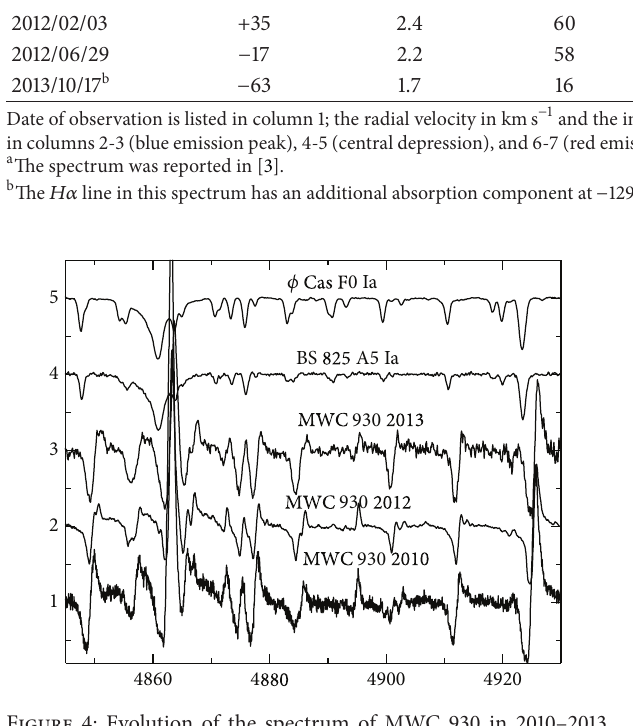
Figure 4: Evolution of the spectrum of MWC 930 in 2010–2013 and comparison with spectra of normal stars. The spectra of BS 825 and 𝜙 Cas were obtained with a resolving power of ∼ 10000 at the Three College Observatory of the University of North Carolina at Greensboro. The intensity and wavelengths are in the same units as in Figure